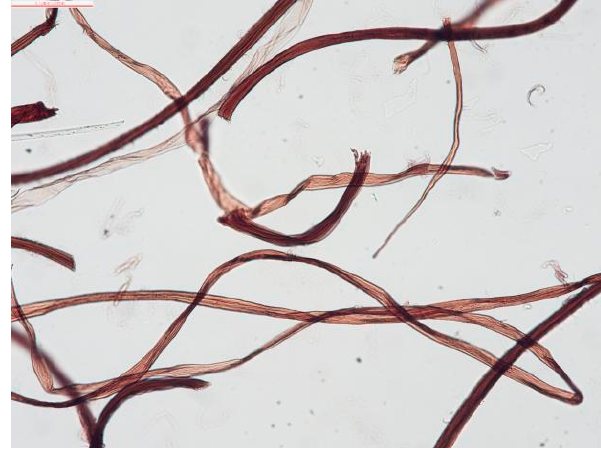
Figure 5. The optical microscopic picture of dyed fibers.